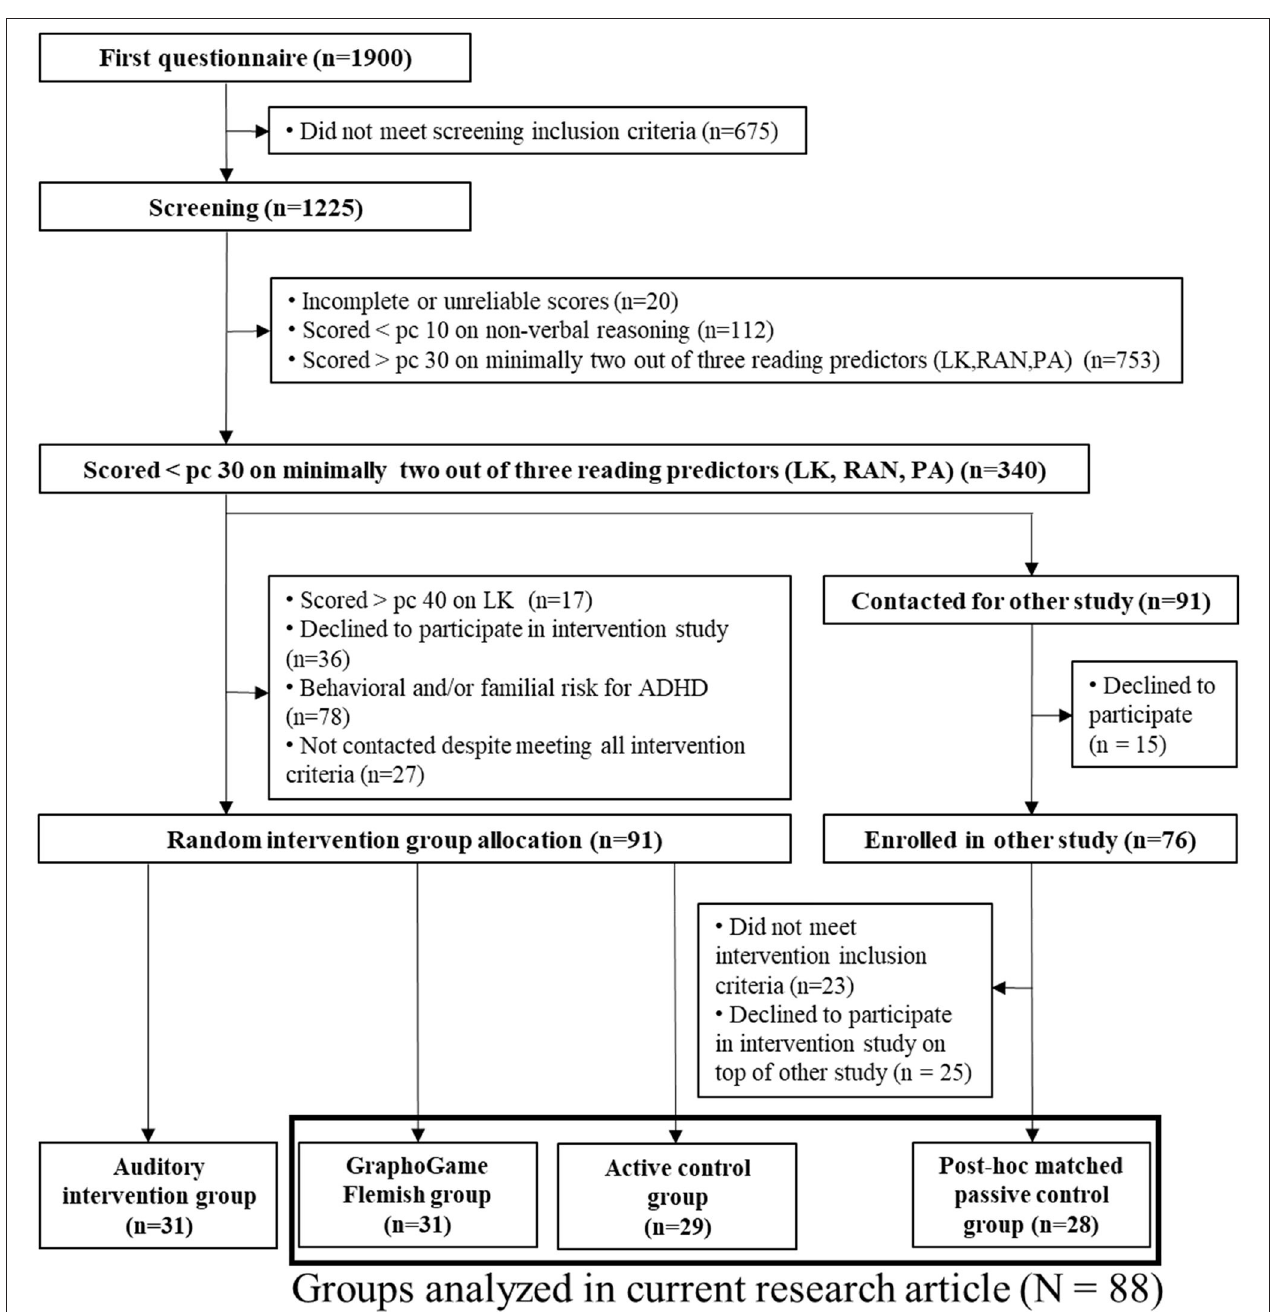
FIGURE 1 | Flowchart of the participant selection from recruitment to group assignment.